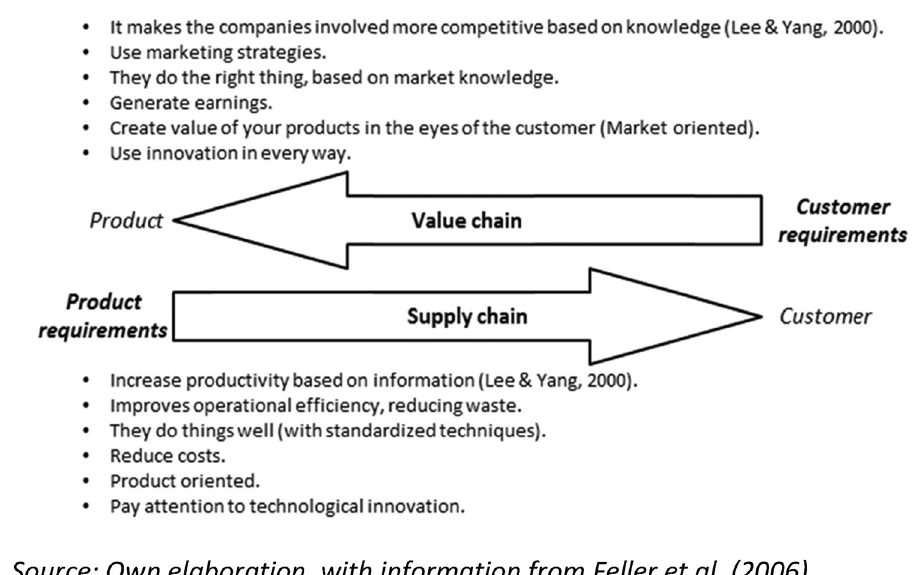
Figure 3: Comparative relationship between the value and supply chains. Source: own elaboration, with information from Feller et al. ( 2006 )